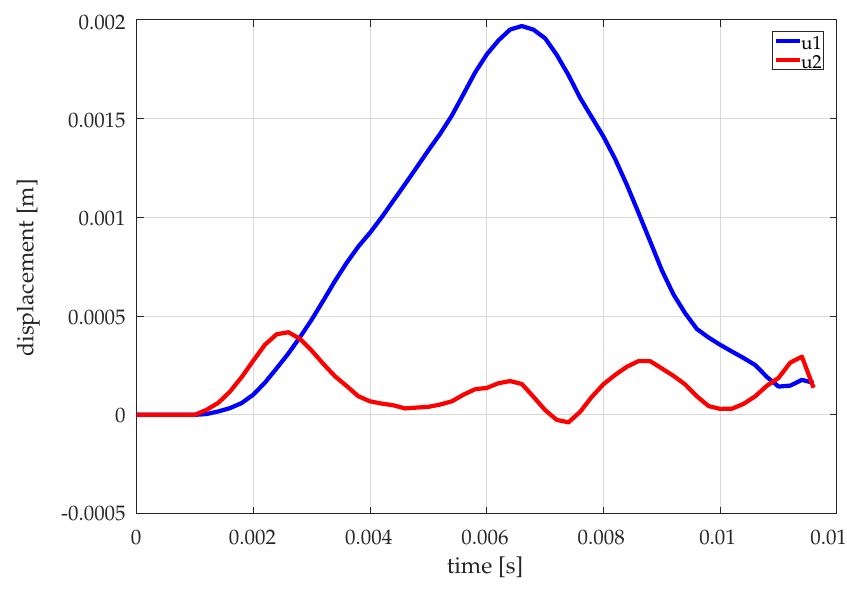
Figure 9. Displacement of the top of the vocal